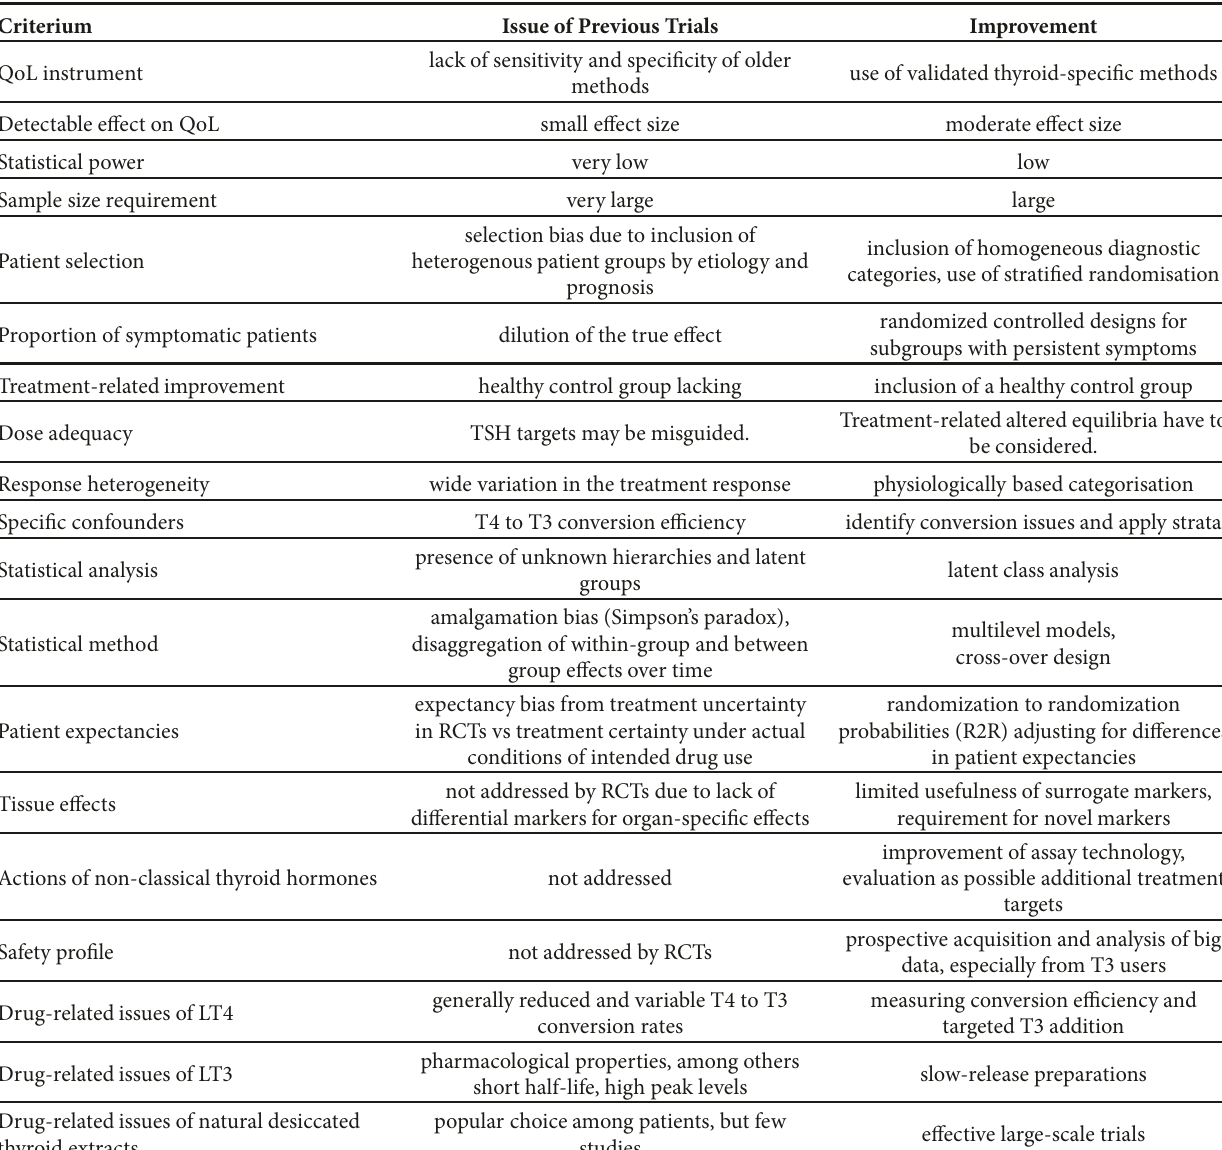
Table 1: Suggestions for improvement in trial design for randomised controlled T3/T4 combination